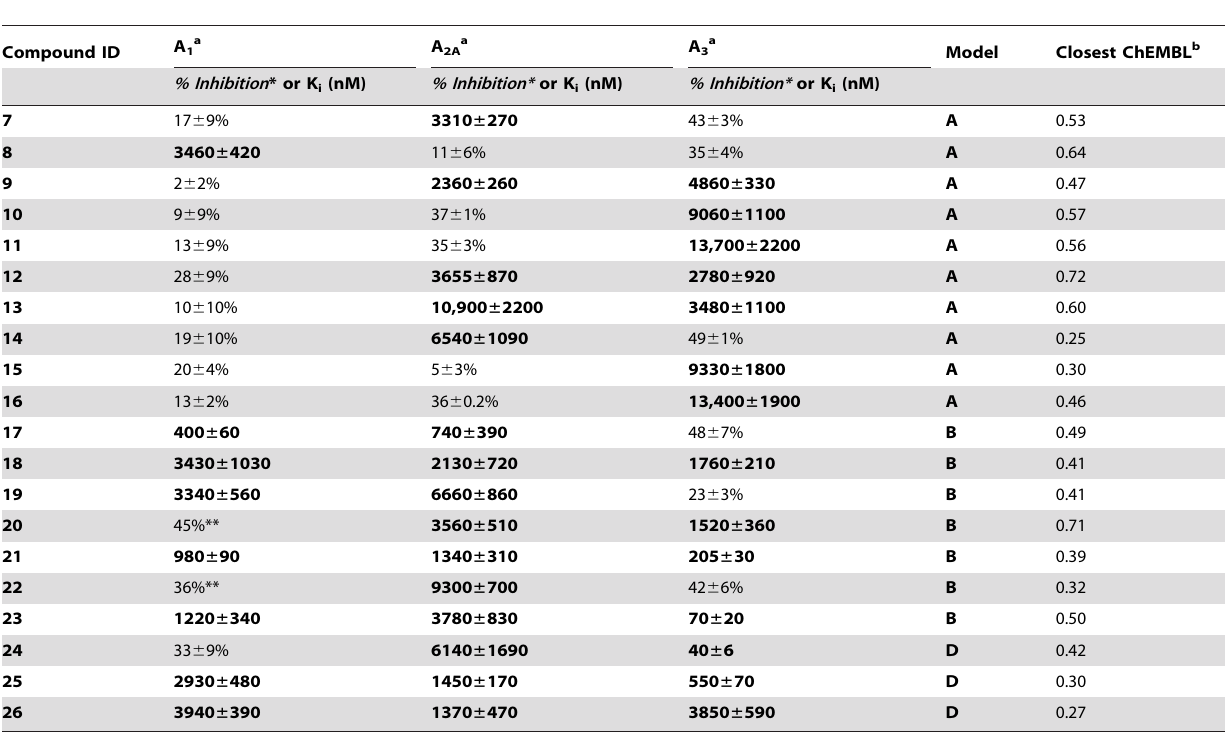
Table 1. In vitro affinity in binding to three subtypes of hARs of diverse heterocyclic derivatives identified through their high ranks in the in silico screen (structures are shown in Chart 2).